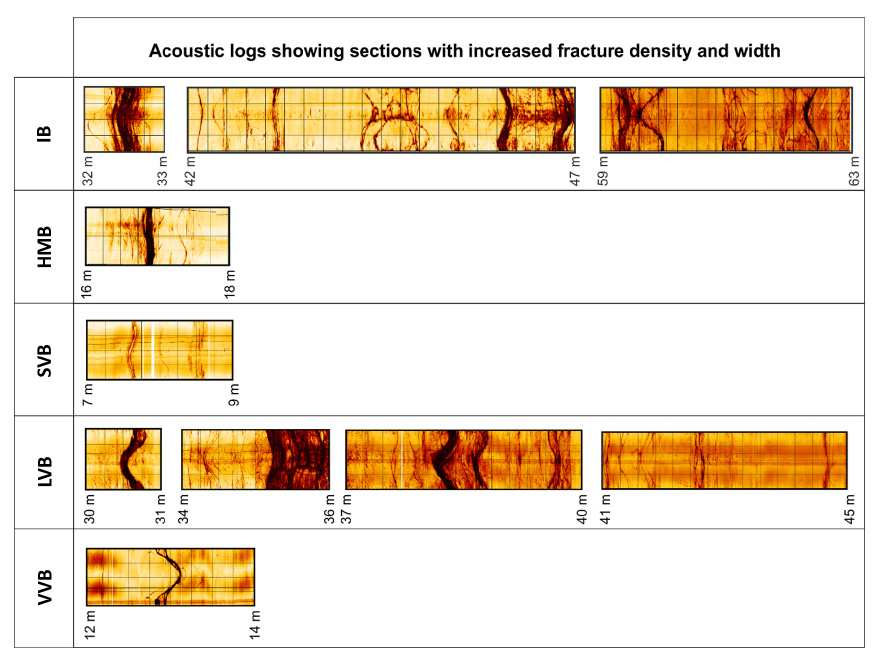
Figure 2. Acoustic borehole televiewer logs indicating sections along the boreholes with increased fracture density and width, intercepted by the injection borehole (IB), hydraulic monitoring borehole (HMB), short inclined borehole (SVB), long inclined borehole (LVB) and vertical validation (VVB) borehole. Modified from Adero